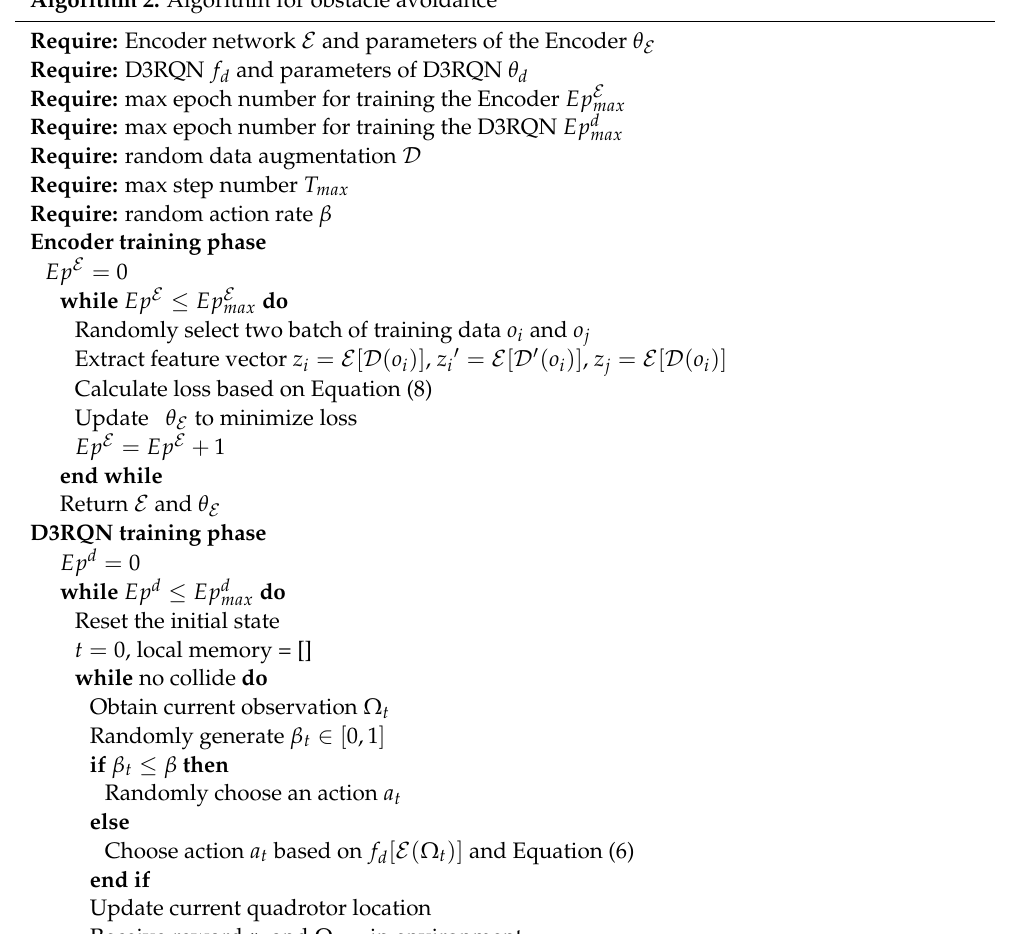
Algorithm 2. Algorithm for obstacle